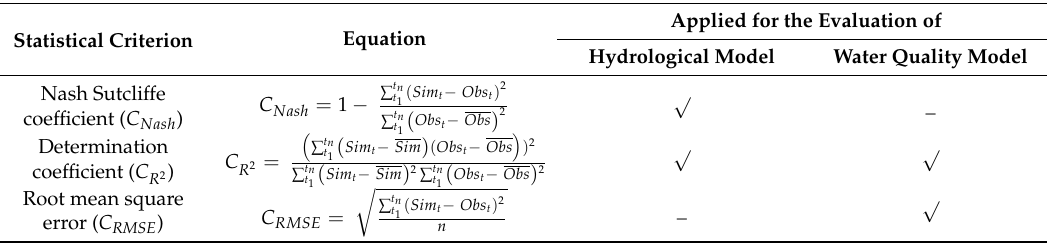
Table 2. Evaluation criteria of the performance of hydrological and water quality models. Sim t is the simulated value at time t ; Obs t is the observed value at time t ; Sim is the average of the simulated values; Obs is the average of the observed values; t 1 is the beginning of the simulated event; t n is the end of the simulated event; n is the total duration of the simulated